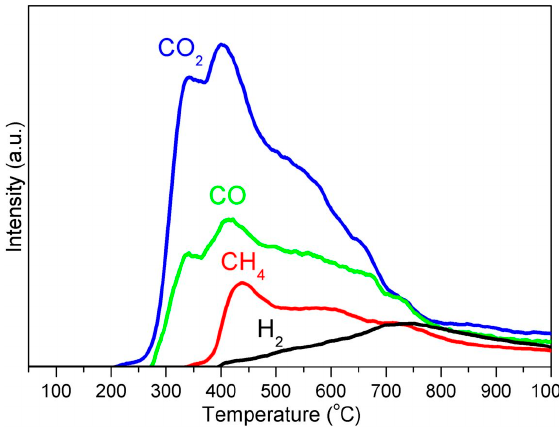
Figure 5. Gas evolution profiles of during thermal treatment of the KL/Fe precursor.